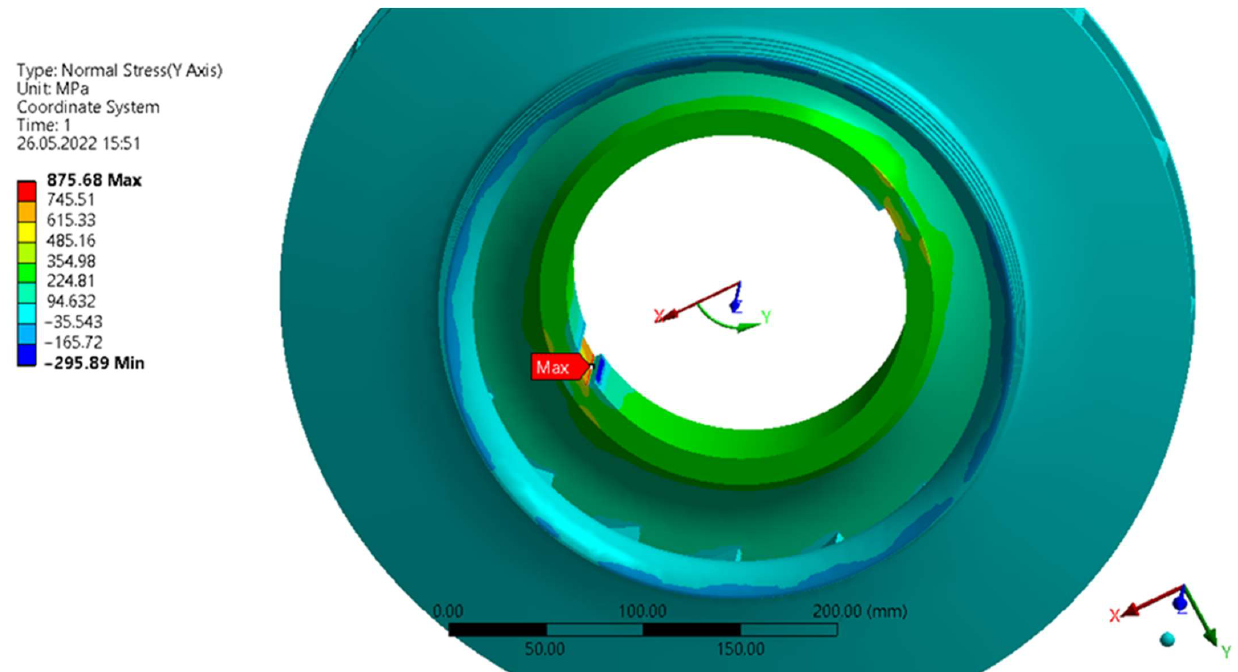
Figure 8. Hoop stress distribution caused by the shrink fit and the presence of the keyways.